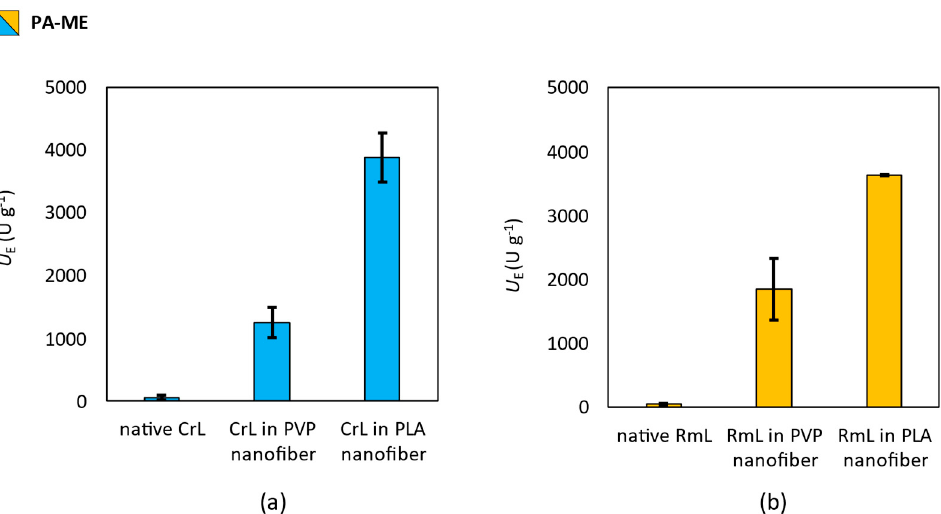
Figure 6. Investigation of the effect of entrapment by electrospinning into PVP and PLA nanofibers on the biocatalytic activity of ( a ) lipase from Candida rugosa (CrL) and ( b ) lipase from Rhizomucor miehei (RmL) in the biocatalyzed hydrolysis of methyl palmitate ( PA-ME ). Test reactions were carried out at 33 °C constant shaking. This figure summarizes the specific enzyme activity values obtained by gas chromatography of samples taken 2 h after the start of the reactions. Activity values were determined by the following equation: U E = n s × c × ( t × m E ) − 1 , where c is the conversion (%) n S is the amount of substrate [ μ mol], t is the time [min] and m E is the mass of enzyme [g].